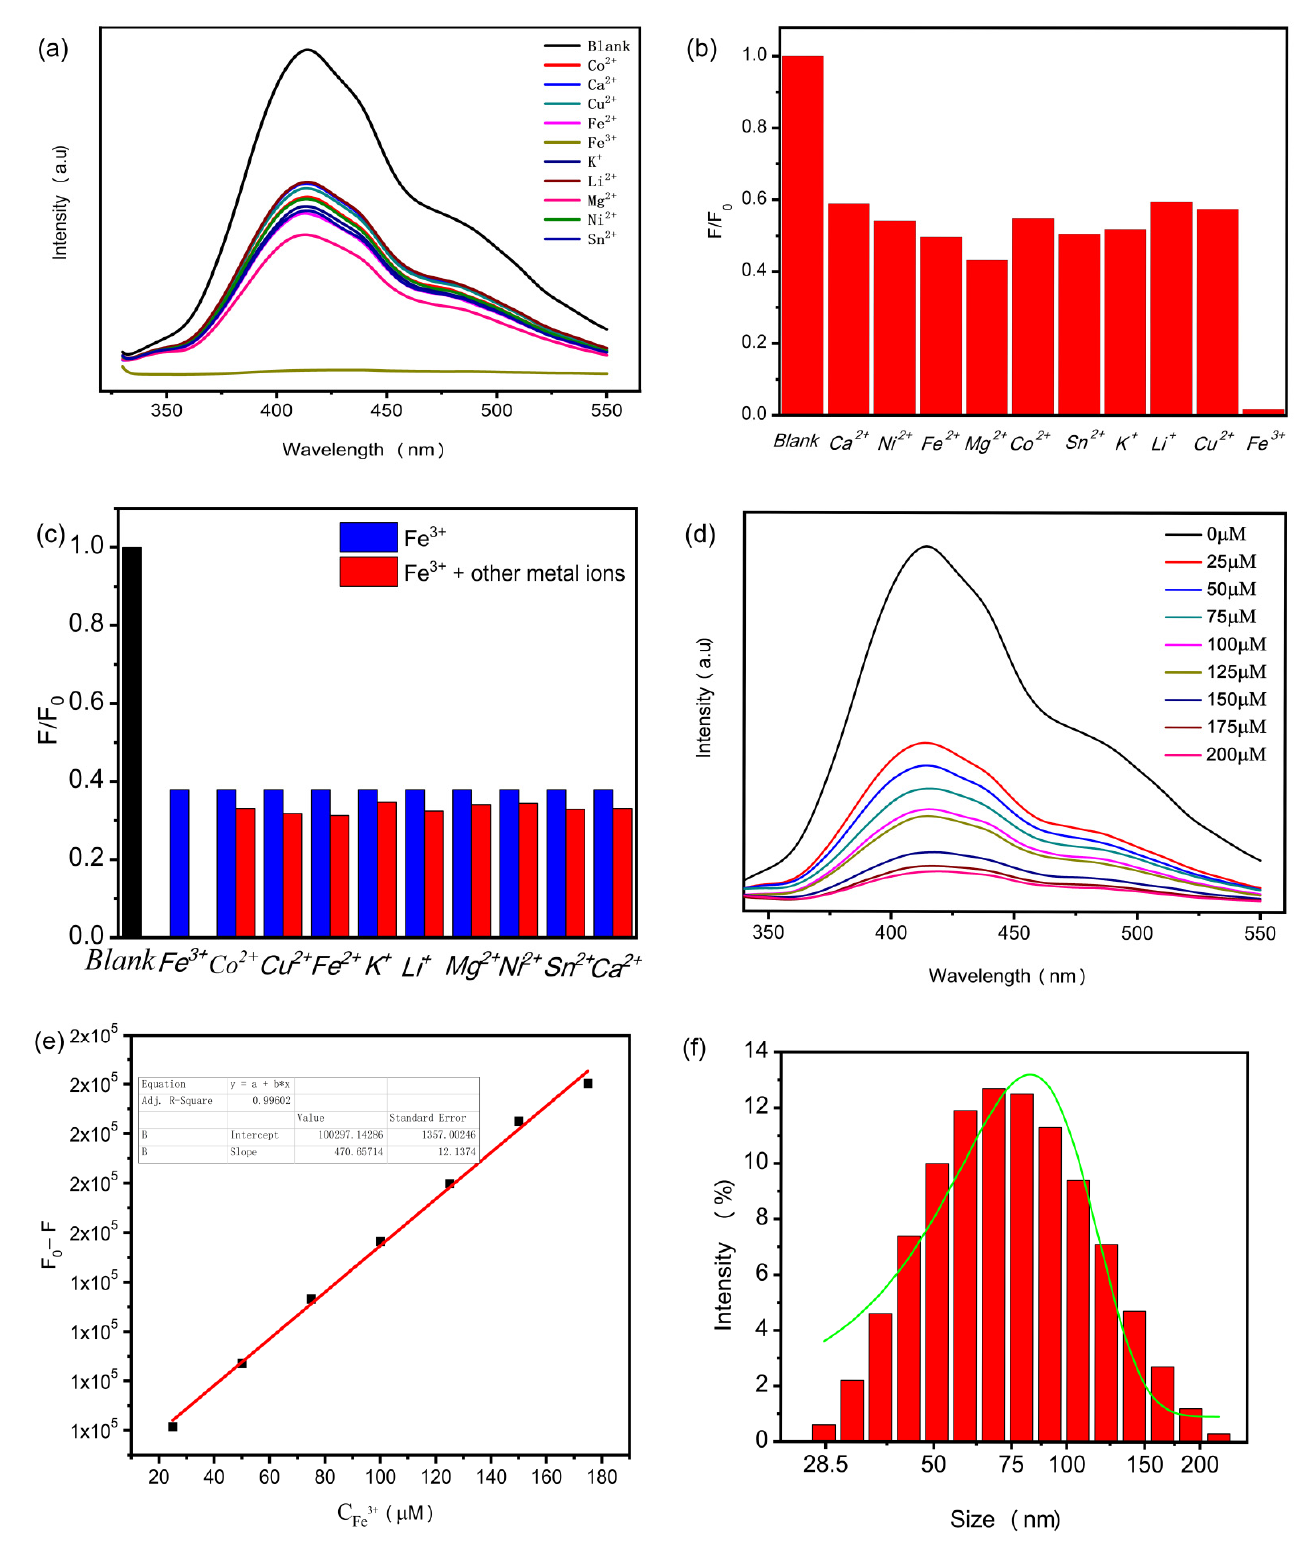
Figure 5. ( a , b ) Selectivity of N-CQDs for various metal ions, ( c ) The fluorescence intensities of N-CQDs in presence of Fe 3+ with various interfering metal ions, ( d ) Fluorescence spectra of N-CQDs solution with various Fe 3+ concentrations, ( e ) The linearity between the quenching efficiency ( F − F 0 ) and Fe 3+ concentrations, ( f ) Histogram of size distribution of N-CQDs in the presence of Fe 3+ ions.